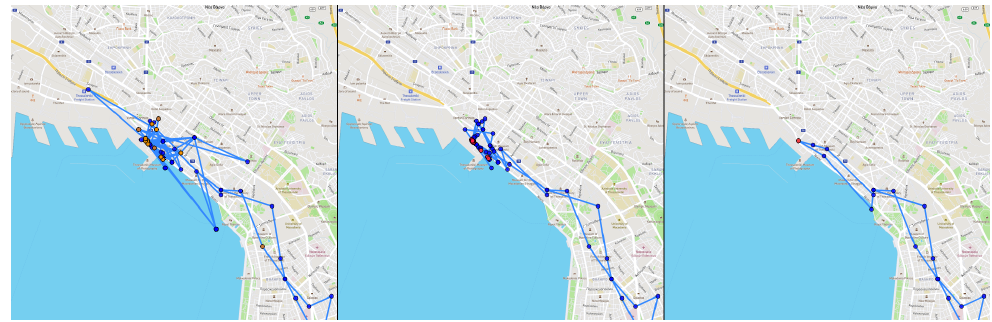
Figure 11. Multi-clustering. Raw ( left ), first interaction ( center ), second interaction ( right